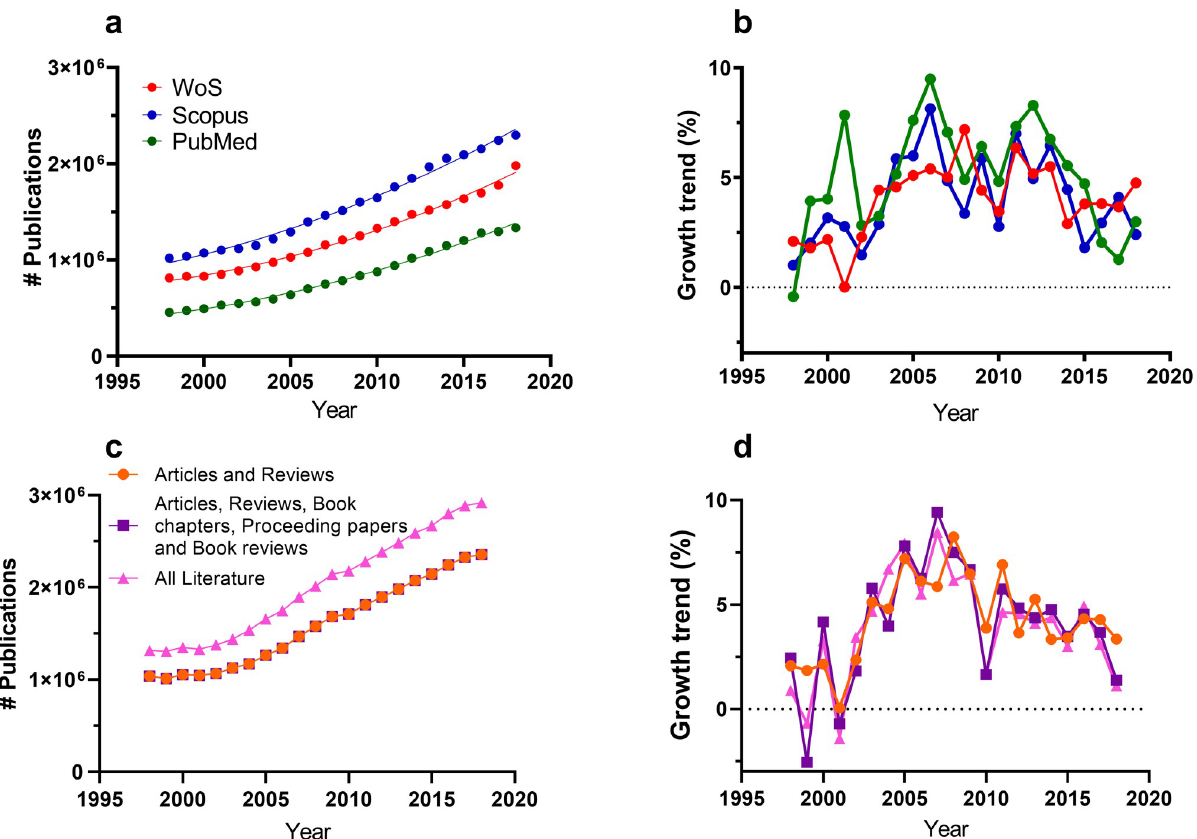
Fig 1. Trend of the overall publication output in science. Total publications (a) and yearly percentage increase (b) on WoS excluding ESCI index (red), Scopus (blue) and PubMed (green) databases for all scientific publications published between 1998 and 2018. Lines in (a) are fitted quadratic trend lines. Lines in (b) connect individual data points. Search term used in WoS was: “PY = 1998–2018”. In Scopus: PUBYEAR AFT 1998. In PubMed 1998:2018[dp]. Searches were refined for articles and reviews only. (c) shows total publication output in WoS excluding ESCI index (search term “PY = 1998–2018”) refined for articles and reviews (orange); articles, reviews, book chapters, proceedings papers and book reviews (purple) or all scientific literature listed in WoS (pink). (d) shows yearly percentage increase for the total publication output using the data shown in